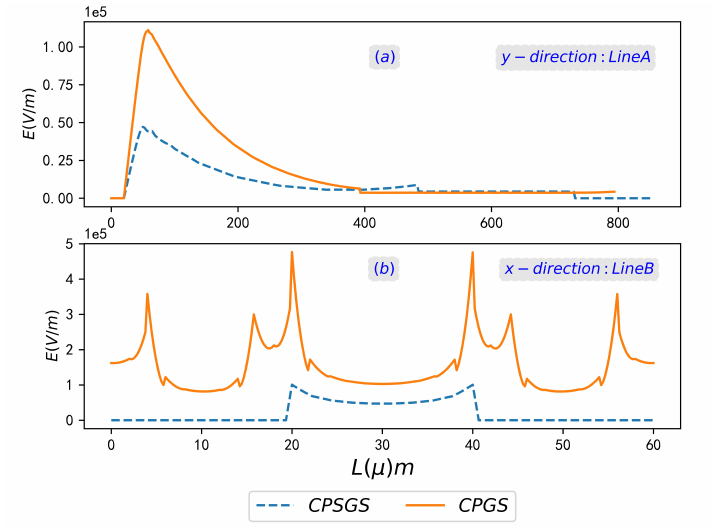
Figure 3. The electric field of SSPPs on CPSGS and CPGS at SPR frequency along the y -direction ( a ) and x -direction ( b